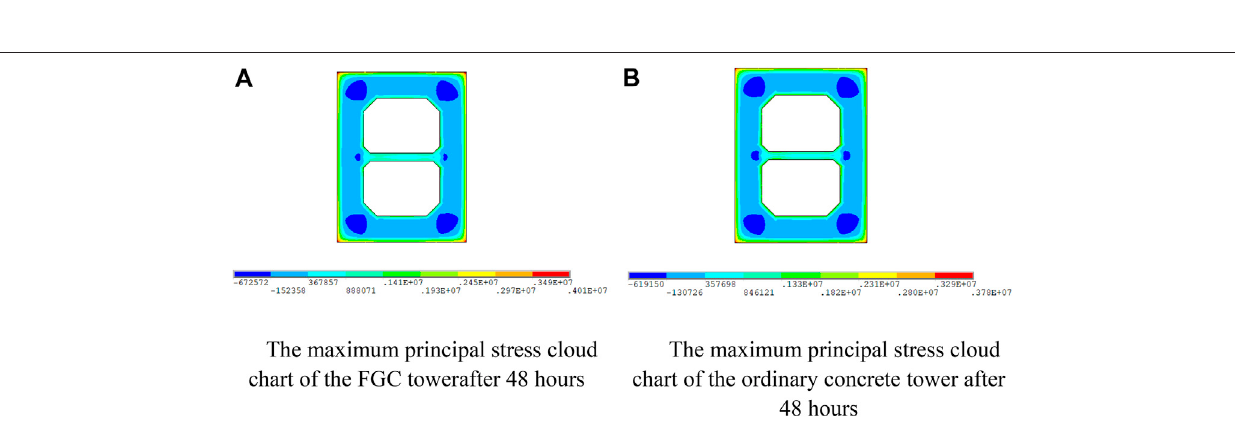
Frontiers in Materials |